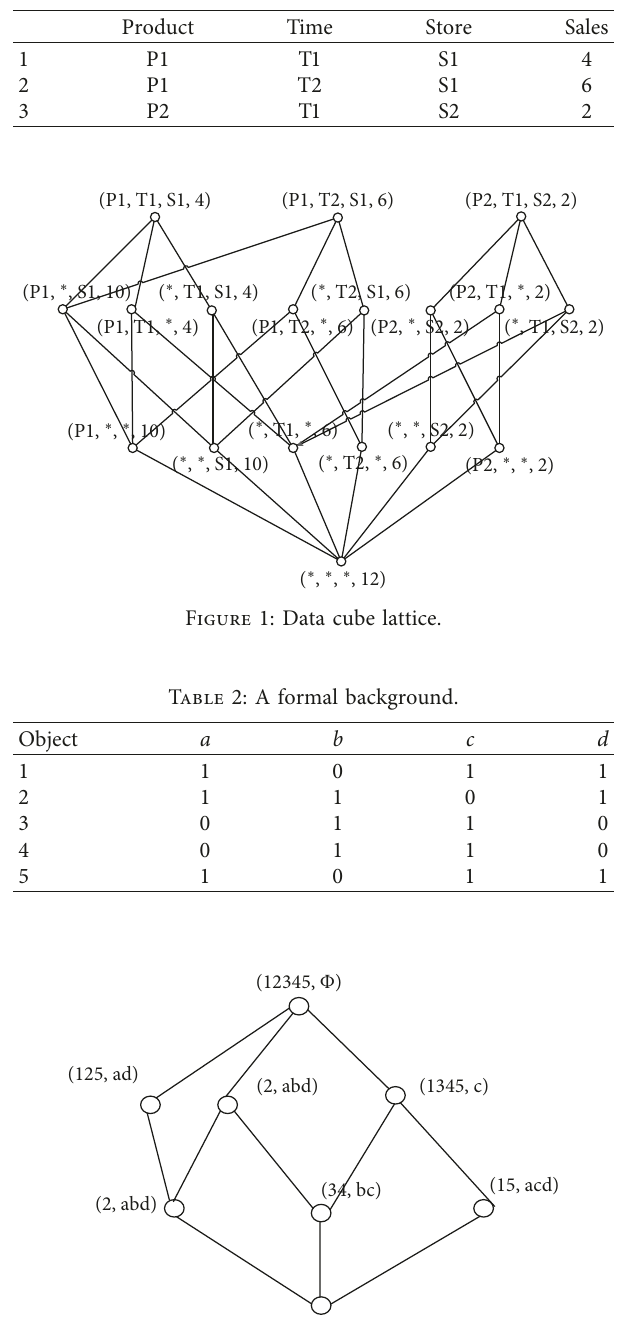
Table 3: The first group